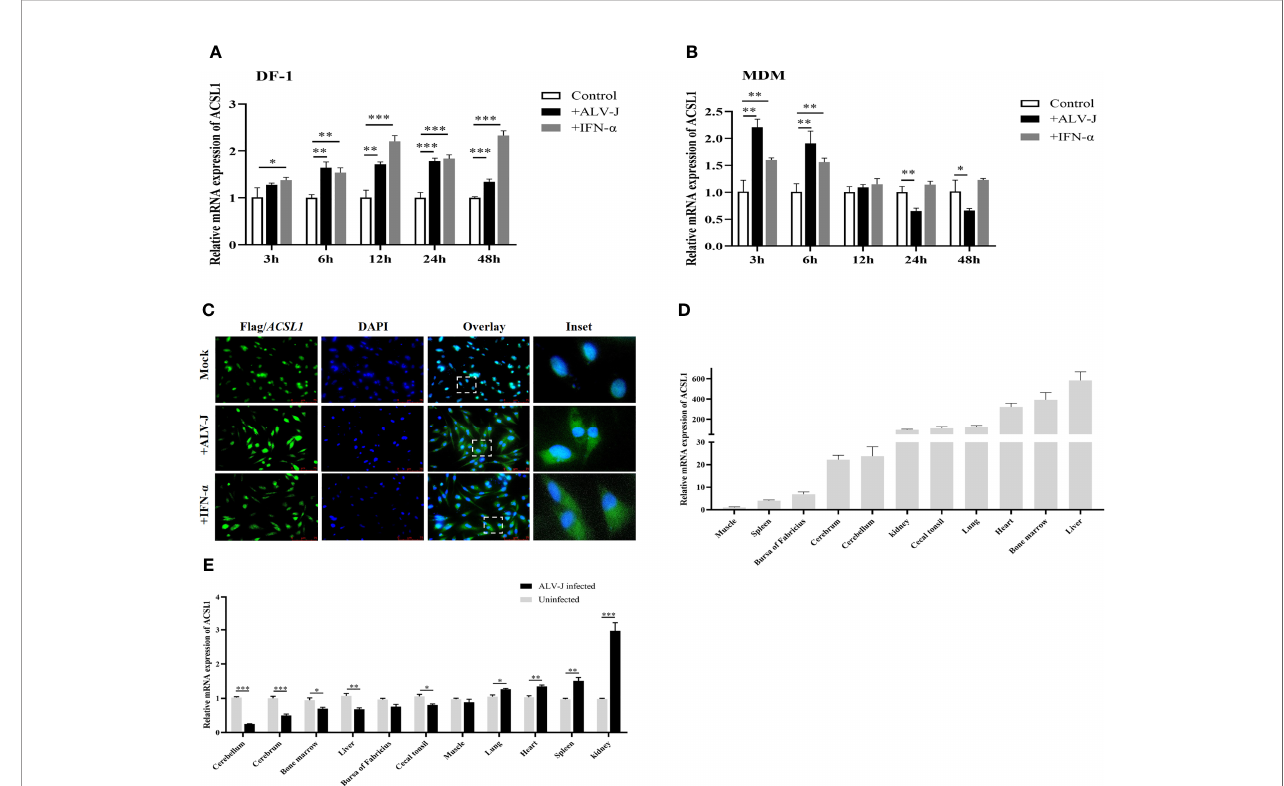
FIGURE 1 | ALV-J infection induces ACSL1 expression, an IFN stimulated gene. (A, B) DF-1 cells (A) and MDMs (B) were infected with ALV-J (10 4 TCID 50 /0.1 ml) or treated with IFN- a (1,000 U/ml) for the indicated time. Relative mRNA levels of ACSL1 were analyzed by quantitative RT-PCR (qRT-PCR). (C) Flag- ACSL1 was expressed in DF-1 cells for 24 h, then the cells were infected with ALV-J (10 4 TCID 50 /0.1 ml) or treated with IFN- a (1,000 U/ml). Immuno fl uorescence with anti-Flag antibody was used to detect the overexpressed protein (green). Nuclear was identi fi ed by DAPI (blue). Scale bar, 75 m m. Experiments were repeated at least three times independently, with similar results obtained. (D) Distribution of ACSL1 in various speci fi c-pathogen-free (SPF) White Leghorn chicken tissue following intraperitoneal injection of serum-free DMEM was determined using qRT-PCR analysis. (E) ACSL1 mRNA expression change in various speci fi c-pathogen-free (SPF) White Leghorn chicken tissue following intraperitoneal injection of ALV-J (0.2 ml, 10 4 TCID 50 /0.1 ml) determined by qRT-PCR. Data shown are the means±SEM (n=3). P values were calculated using two-tailed unpaired Student ’ t-test. Differences with p<0.05 were considered signi fi cant. *P < 0.05, **P < 0.01, ***P <